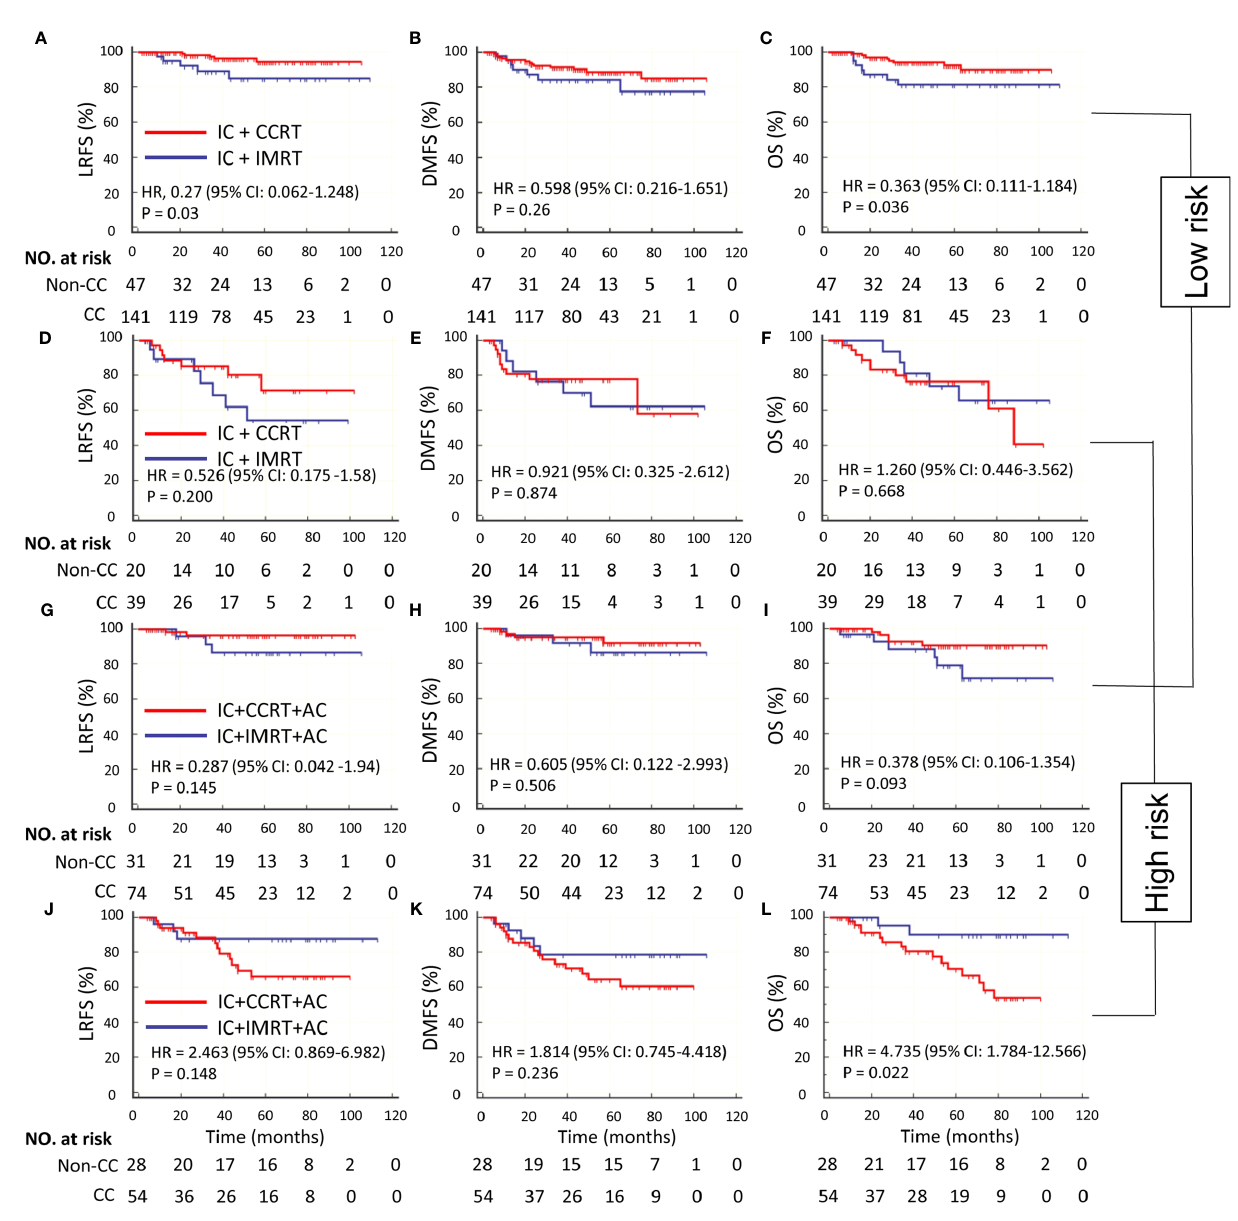
FIGURE 4 | Kaplan – Meier survival curves of LRFS, DMFS, and OS in IC ± CC cohort with low risk (A – C) , IC ± CC cohort with high risk (D – F), IC ± CC + AC cohort with low risk (G – I) , and IC ± CC + AC cohort with high risk (J – L) . CC, concurrent chemotherapy; IC, induction chemotherapy; AC, adjuvant chemotherapy; IMRT, intensity-modulated radiotherapy; CCRT, concurrent chemoradiotherapy; LRFS, locoregional recurrence-free survival; DMFS, distant metastasis-free survival; OS, overall